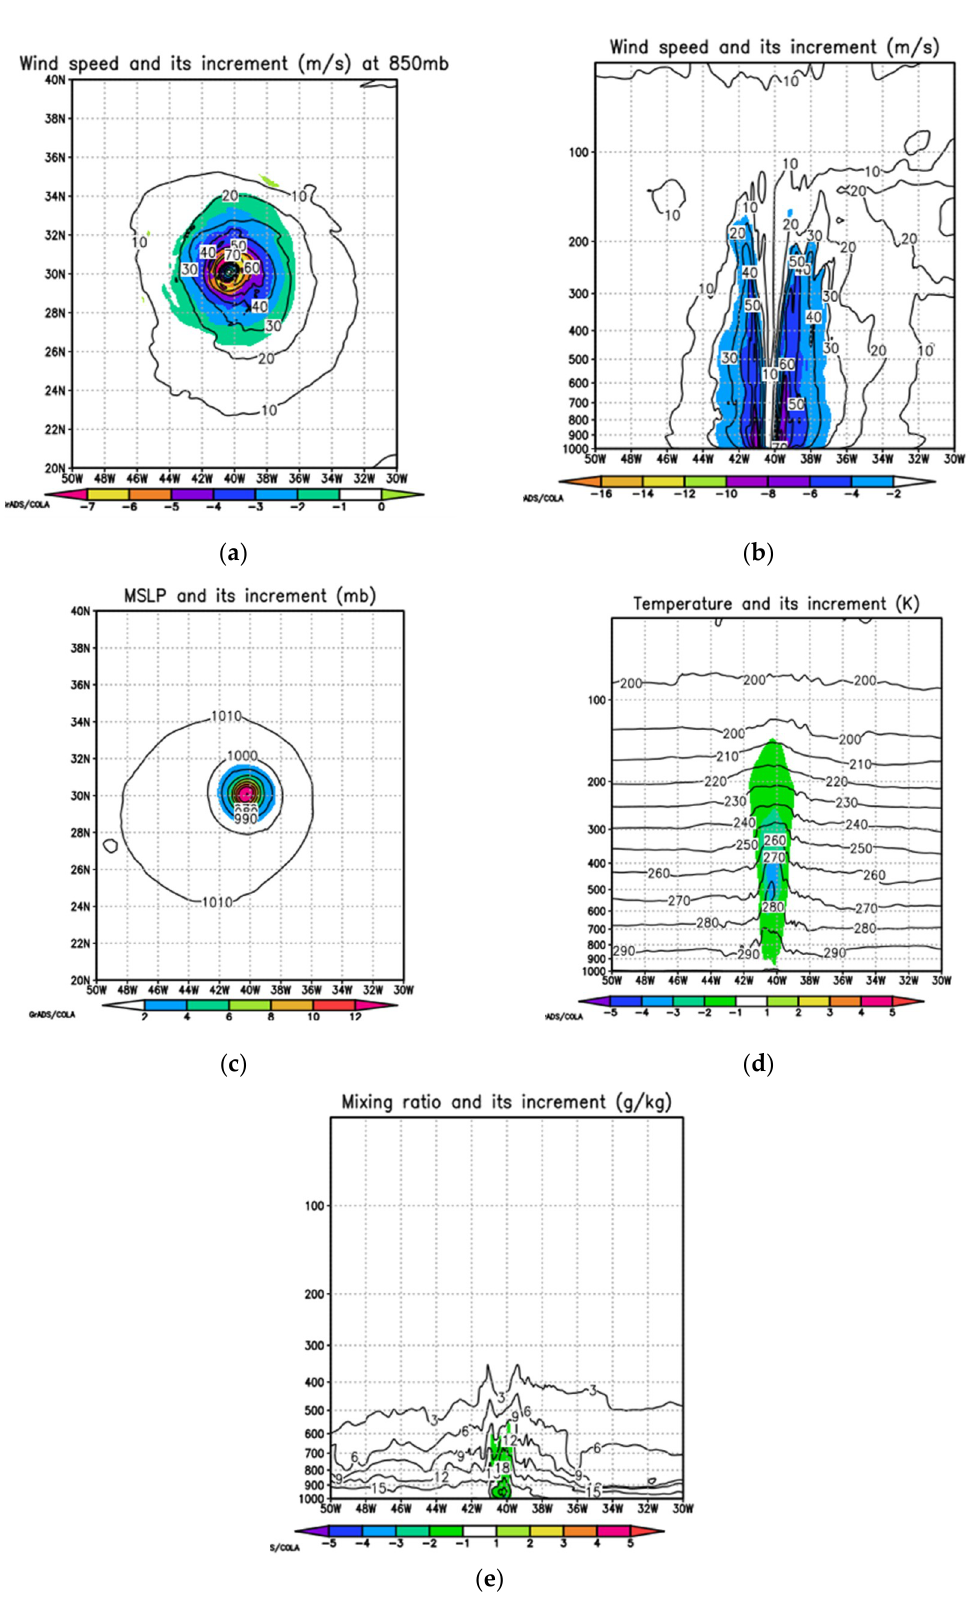
Figure 5. ( a – e ): Same as Figure 2 but after storm intensity corrections in Case I (storm center is located at latitude 30° N).